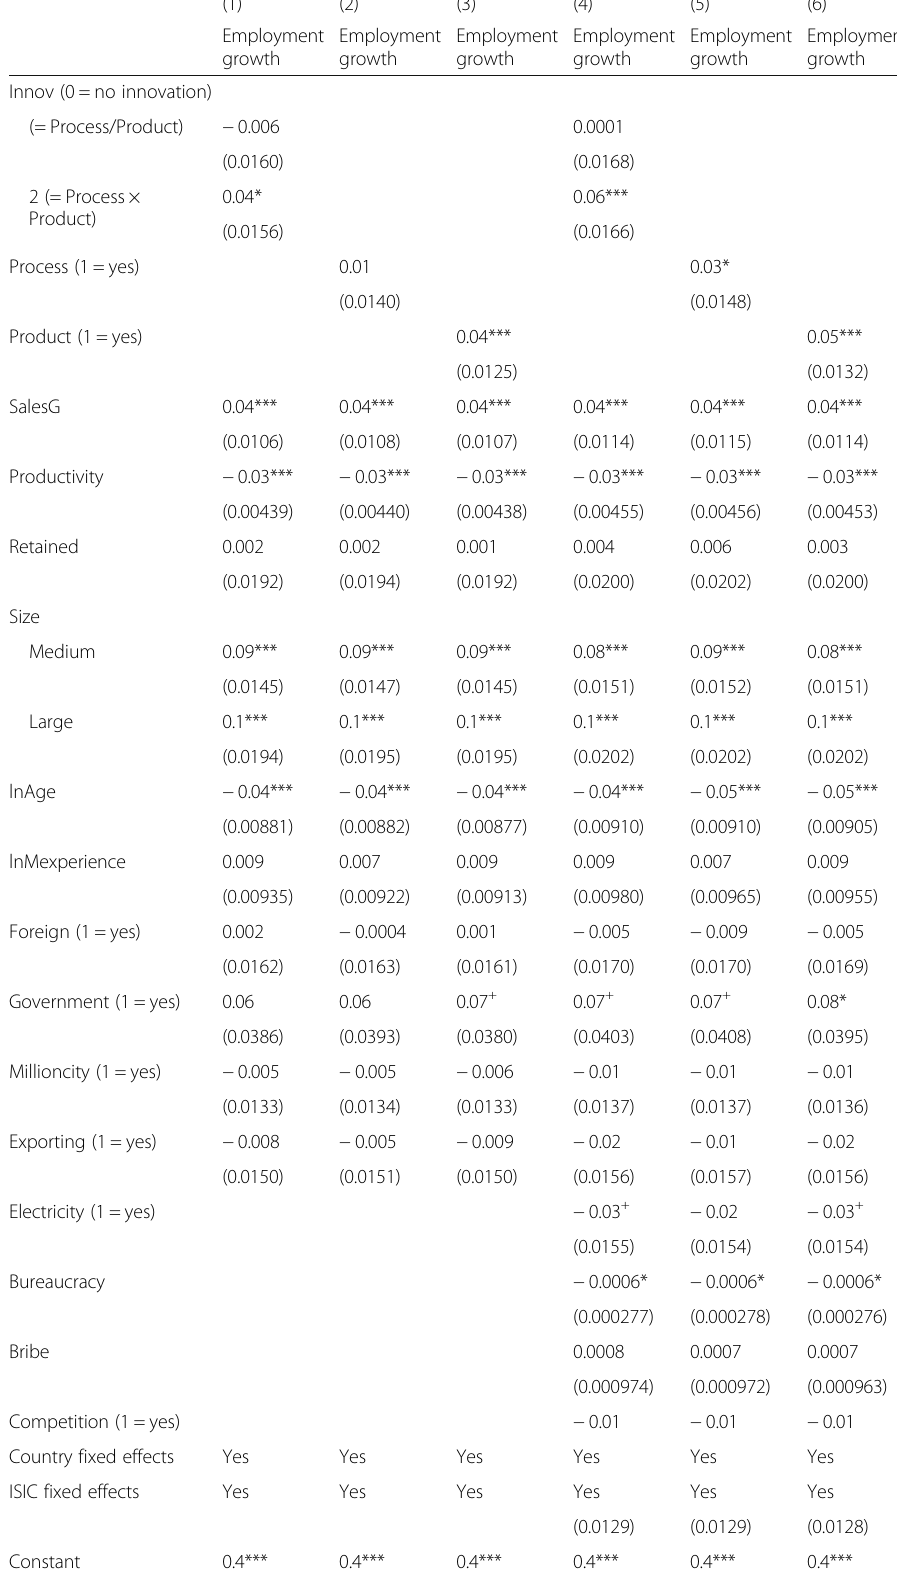
Table 4 Baseline model, employment growth and